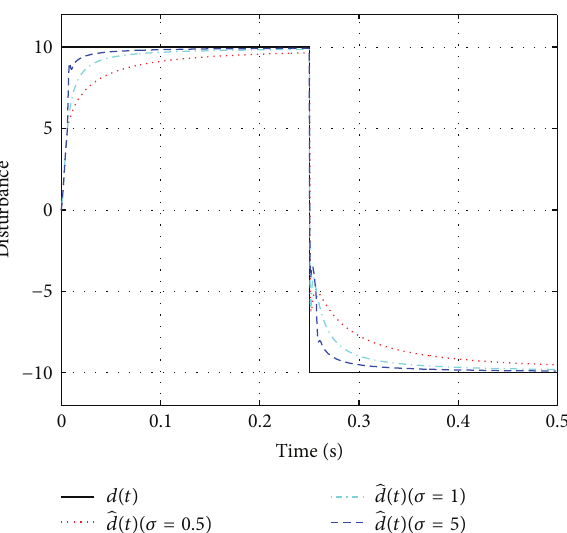
Figure 3: Results of Example 1 with different 𝜎